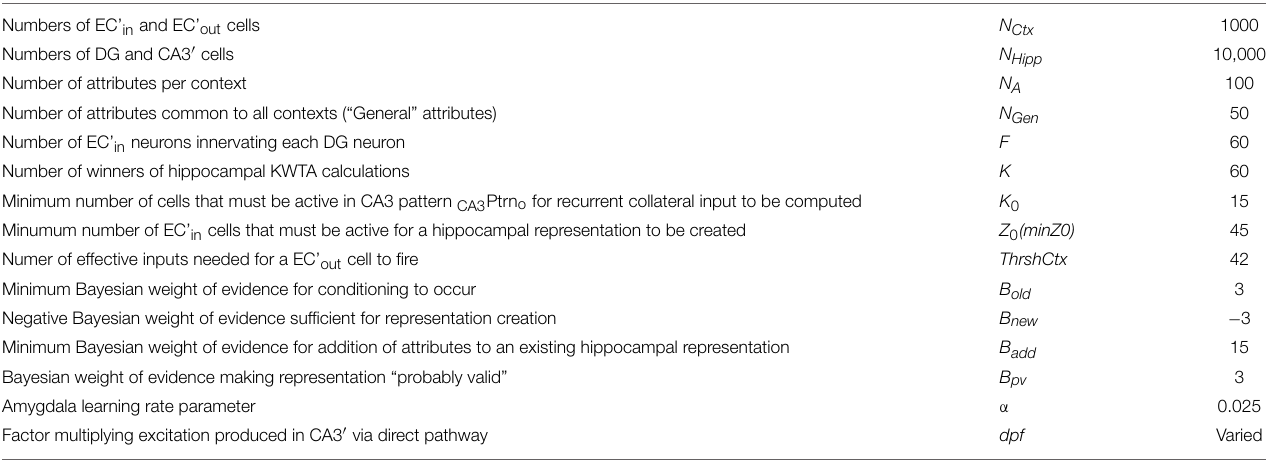
TABLE 2 | BACON parameter definitions and